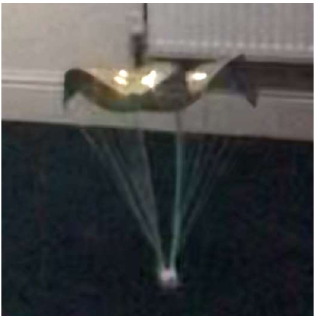
Figure 9. Early Prototype Bug Mylar parawing in flight.